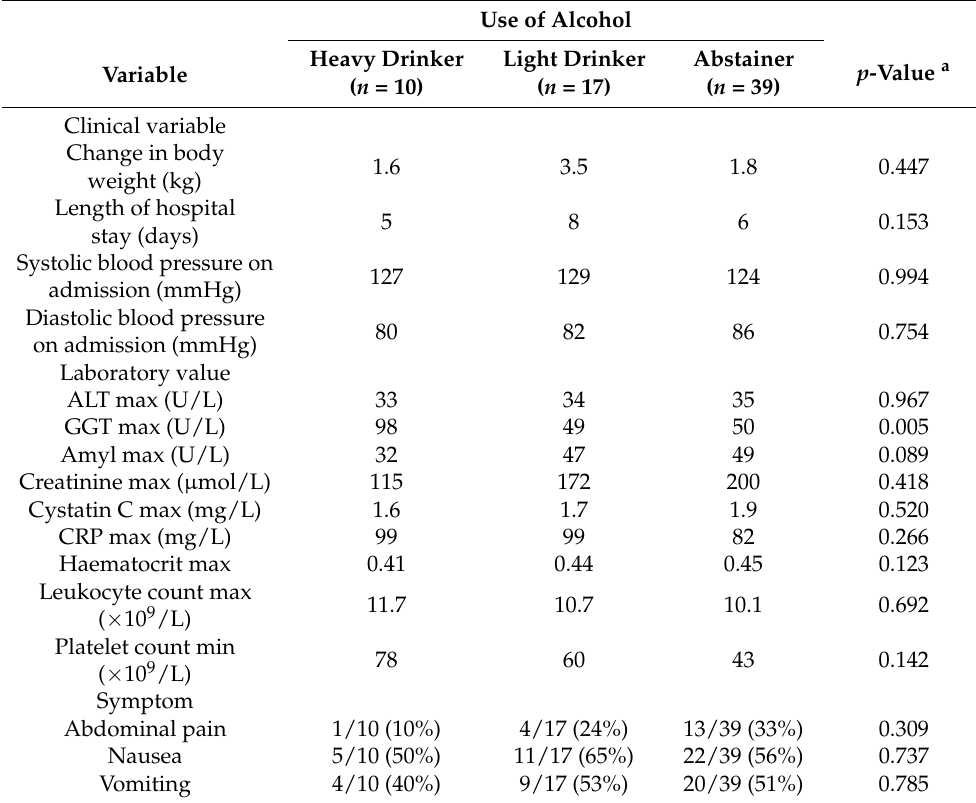
Table 3. Comparison of laboratory values (median of maximum or minimum value) and clinical symptoms among heavy alcohol drinkers, light drinkers, and